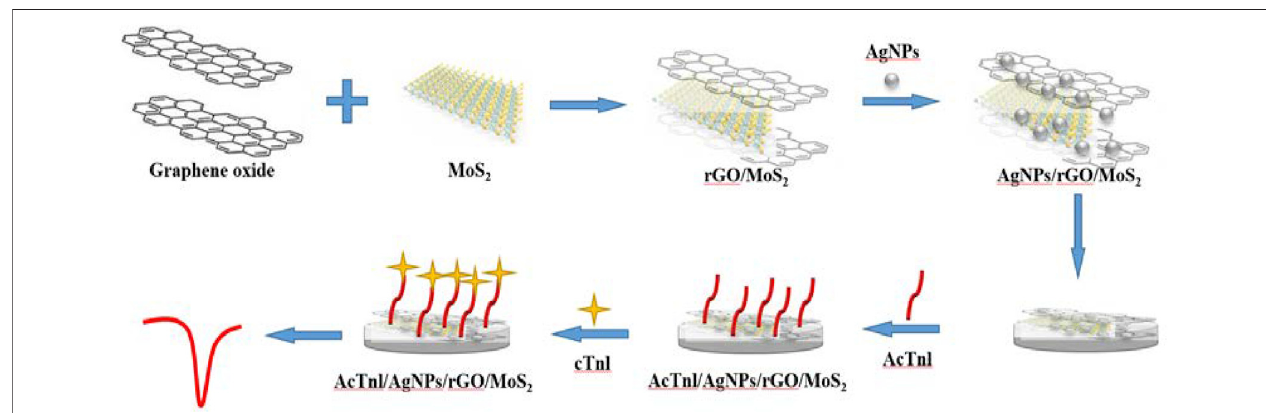
FIGURE 1 | Schematic diagram for the preparation of the AcTnl/AgNPs/MoS 2 /rGO sensor for cTnI detection.